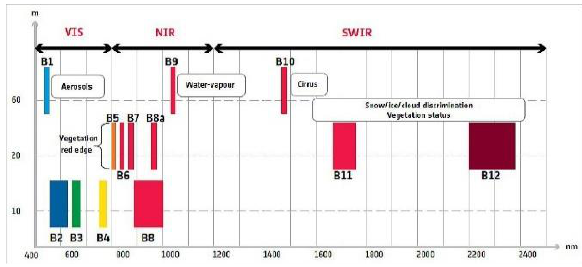
Figure 3. The spectral resolution of Sentinel-2 data (©ESA).